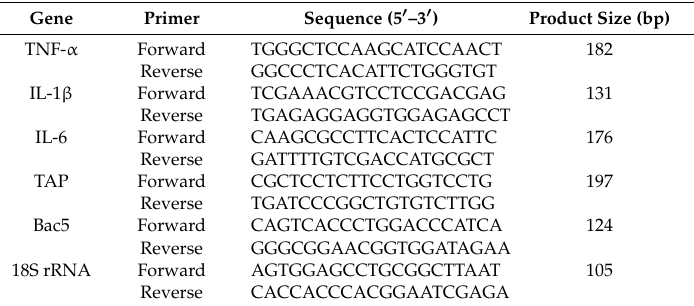
Table 1. Primers used in this study.